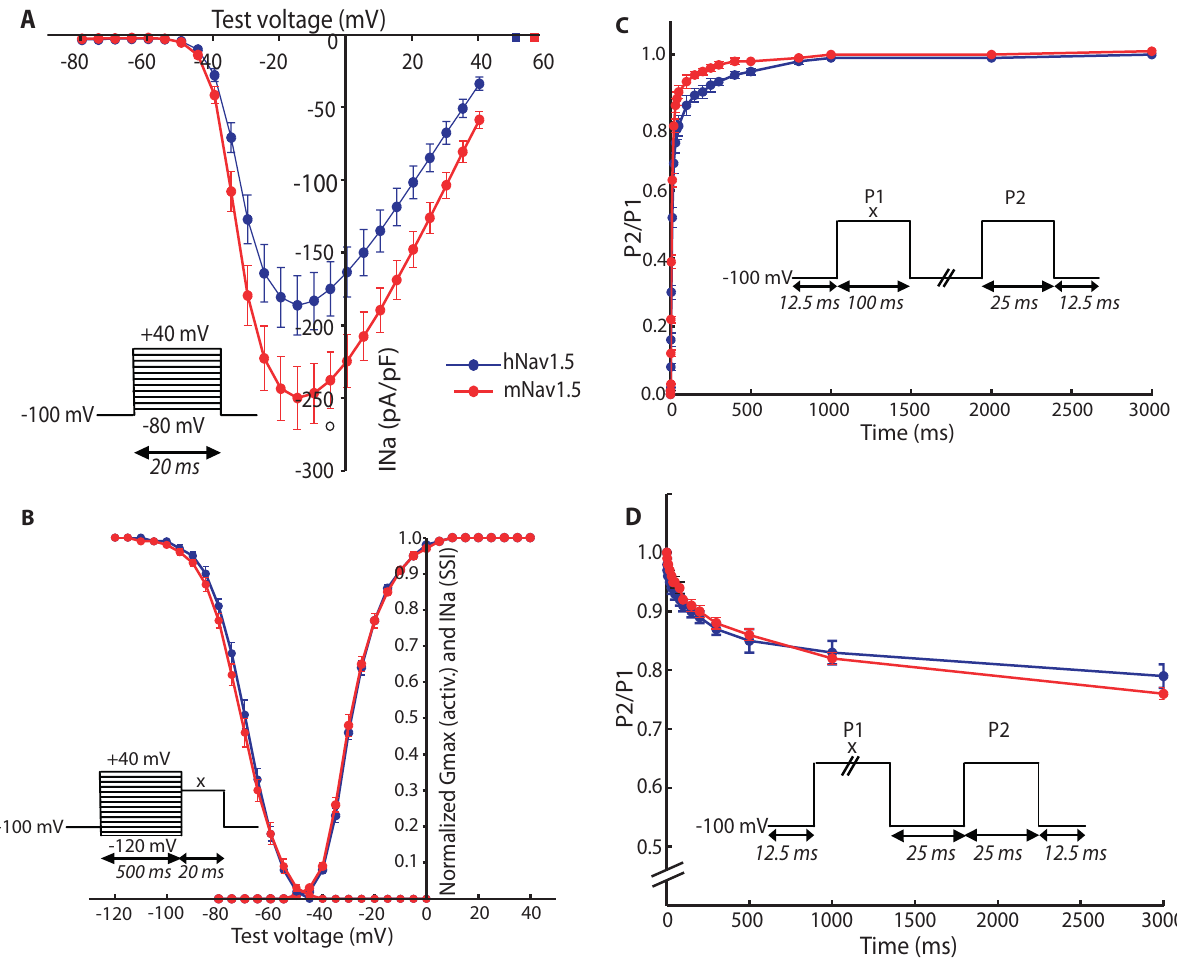
Figure 2. Electrophysiological properties of human and mouse Na 1.5 . The voltage-clamp protocols used are shown in the corresponding v insets. For B–D , the voltage x was adjusted to the voltage that elicited maximum current during the current voltage (I/V)-protocol (-10 to -30 mV). ( A ) I/V-protocol for assessment of reversal potentials. Peak currents were measured for both channels at -15 mV. Calculated reversal potentials are marked with square data points. ( B ) Voltage-dependence of activation and steady-state inactivation (SSI). The data was fitted with the Boltzmann formula. Only the slope of the inactivation curve differs between mouse and human sodium channels (shallower in mNa 1.5). ( C ) Recovery from inactivation. The duration between the depolarising steps was varied from 0.25 to 3000 ms. mNa 1.5 had a slight v v tendency to recover faster than hNa 1.5. ( D ) Onset of slow inactivation. The duration of the first step was varied from 0.25 to 3000 ms. The v relative number of channels entering slow inactivation is similar for both types. ( A–B ) n(hNa 1.5) = 22, n(mNa 1.5) = 17. ( C–D ) n(hNa 1.5) = v v v 9, n(mNa 1.5) = 7. **P<0.01 obtained by two-tailed Student’s t-tests; error bars indicate standard v